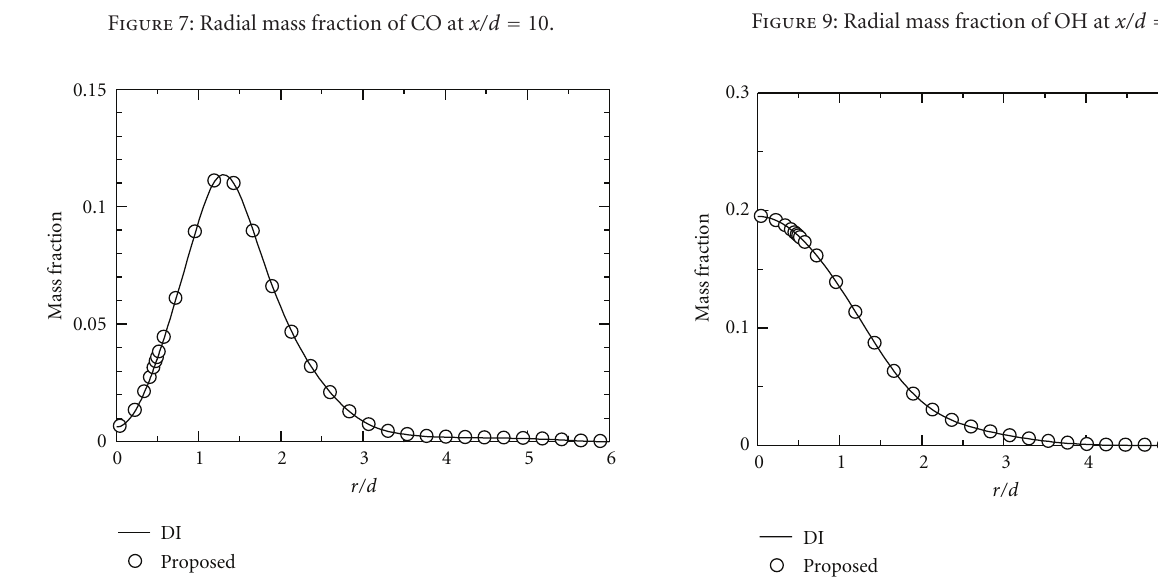
Figure 8: Radial mass fraction of CO 2 at x/d = 10.